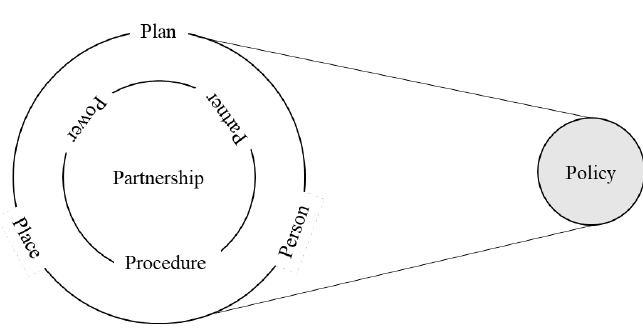
Figure 6. An 8p model of URG.